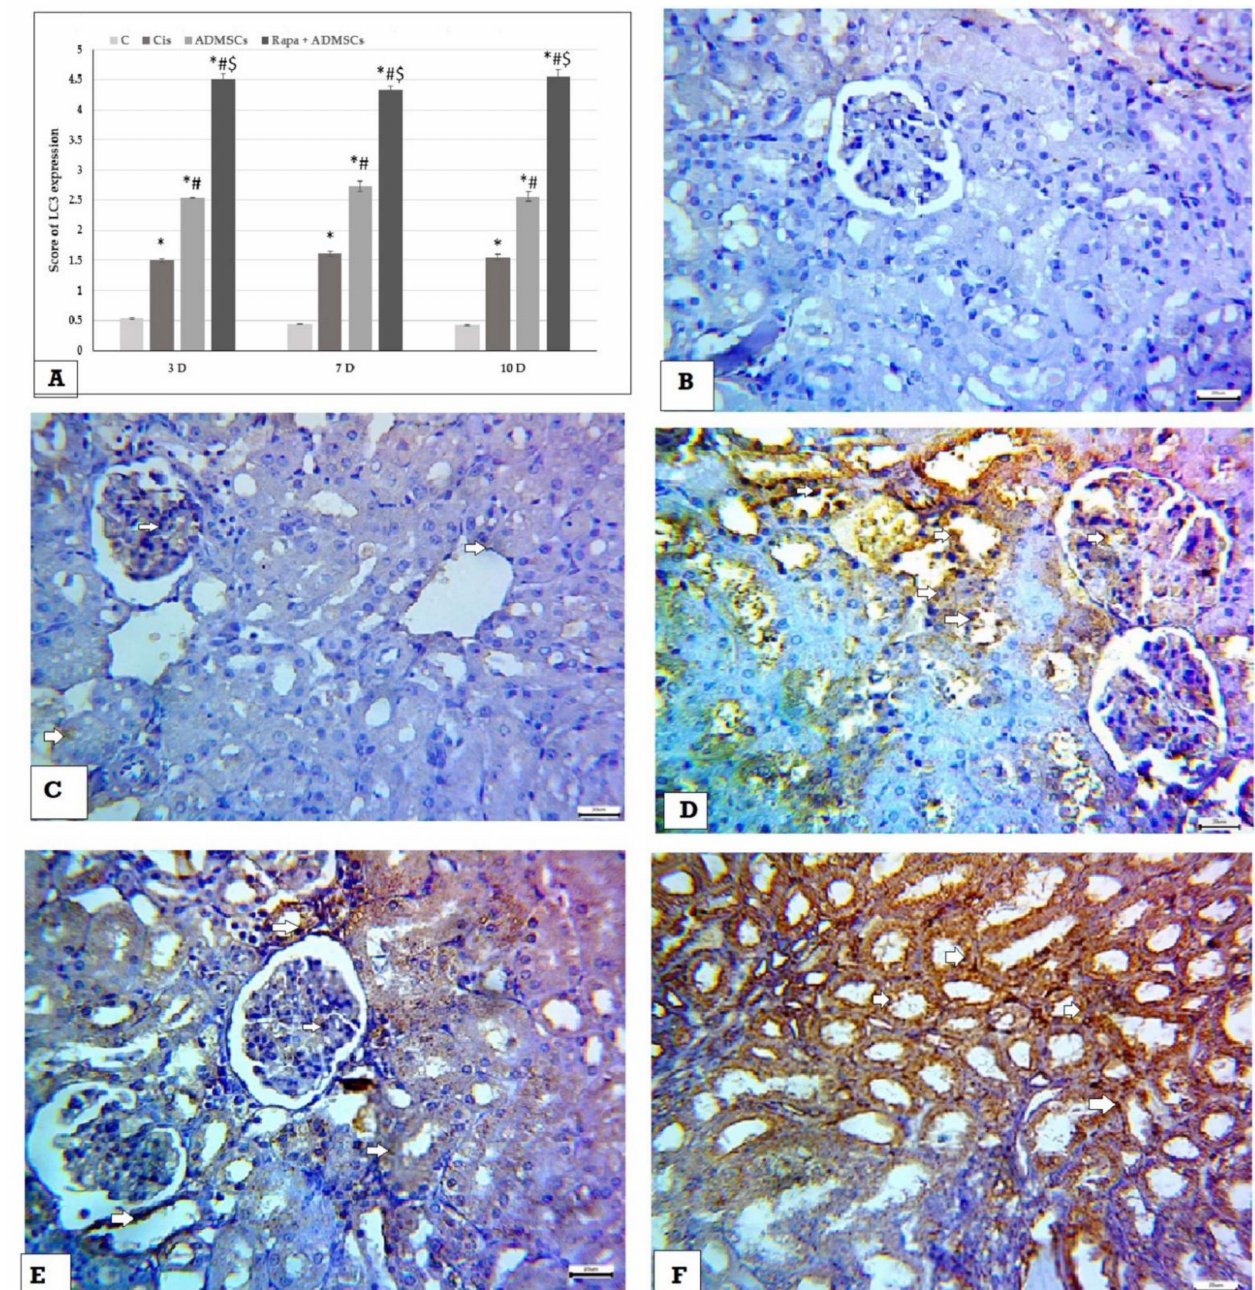
Figure 8. Immunohistochemical analysis of LC3 expression in kidney tissues 400 × ( A ) Im- munoscore of LC3, ( B ) negative expression in control group, ( C ) mild cytoplasmic expres- sion (white arrows) in cisplatin group, ( D ) moderate cytoplasmic expression (white arrows) in ADMSC group, ( E , F ) marked cytoplasmic expression (white arrows) in Rapa + ADMSC group. * Significant vs. control, # significant vs. Cis group and $ significant vs. ADMSCs